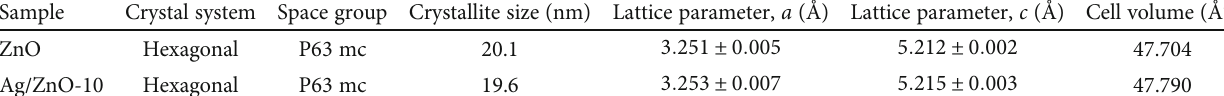
Table 1: Lattice parameters and crystallite sizes of ZnO and Ag/ZnO-10.